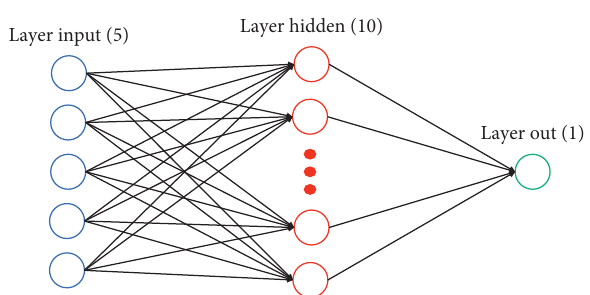
Figure 4: Layout for artificial neural networks for the assessment